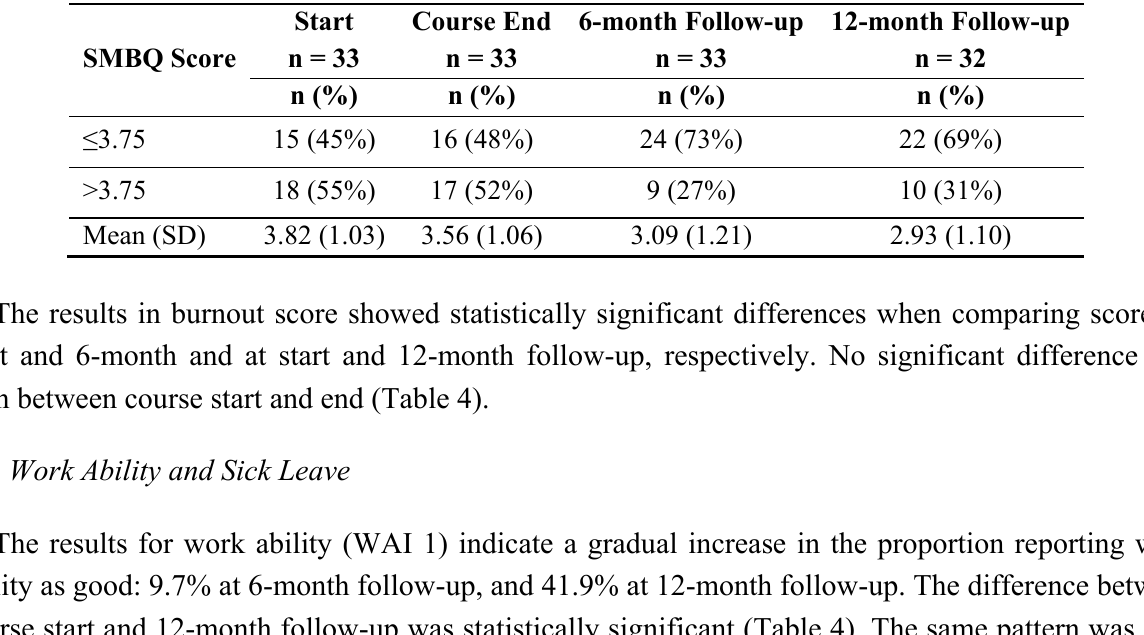
Table 3. Burnout score on the Shirom-Melamed Burnout Questionnaire (SMBQ) at course start, course end and 6- and 12-month follow-up, presented as count and percentage ≤ 3.75 and ˃ 3.75 cut-off and mean and standard deviation